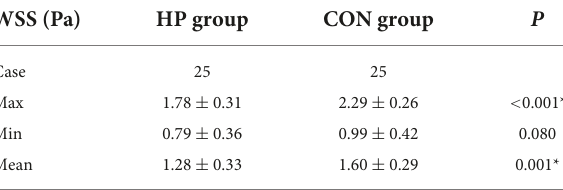
TABLE 2 Carotid WSS parameters of the HP and CON